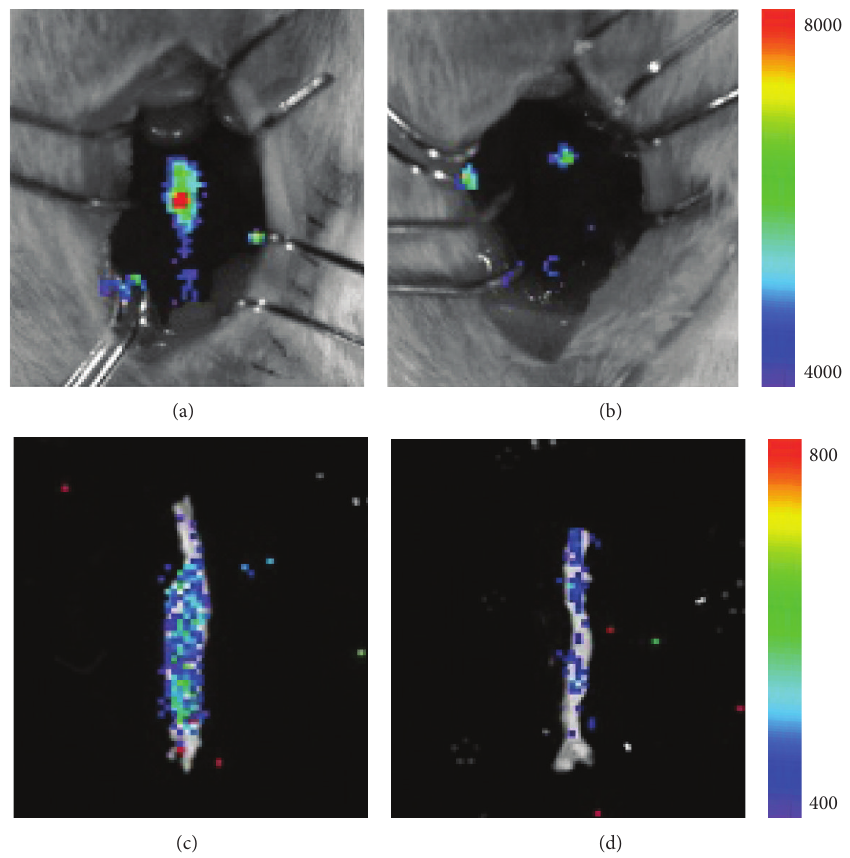
Figure 5: ((a), (b)) In situ and ((c), (d)) ex vivo bioluminescent images of an infrarenal abdominal aortic aneurysm ((a), (c)) and control vessel ((b), (d)), with arbitrary units. Aneurysms were induced via elastase perfusion. Figure adapted from